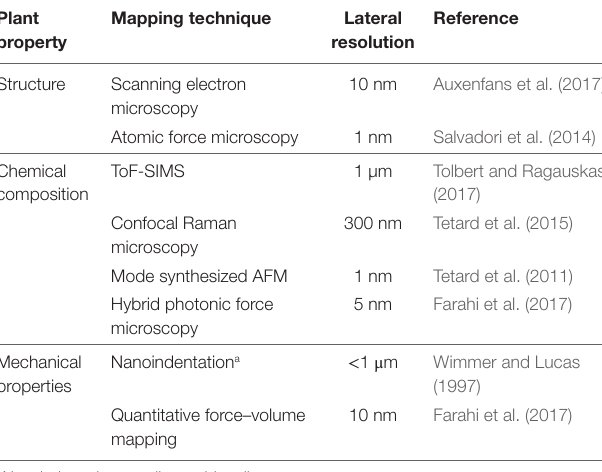
TABLe 1 | Available methodologies for mapping the structure, the chemical composition, and the mechanical properties of plants at the submicron